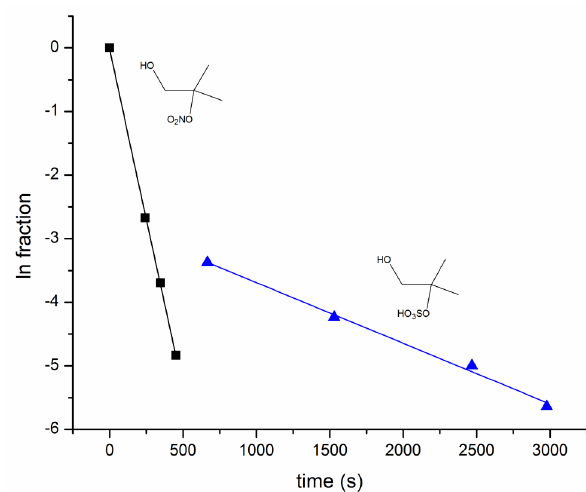
Fig. 3. Pseudo first order kinetics analysis for the hydrolysis of 2-methyl-2-nitrato-1-propanol and 2-methyl-2-sulfato-1-propanol from the data in Figure 2.